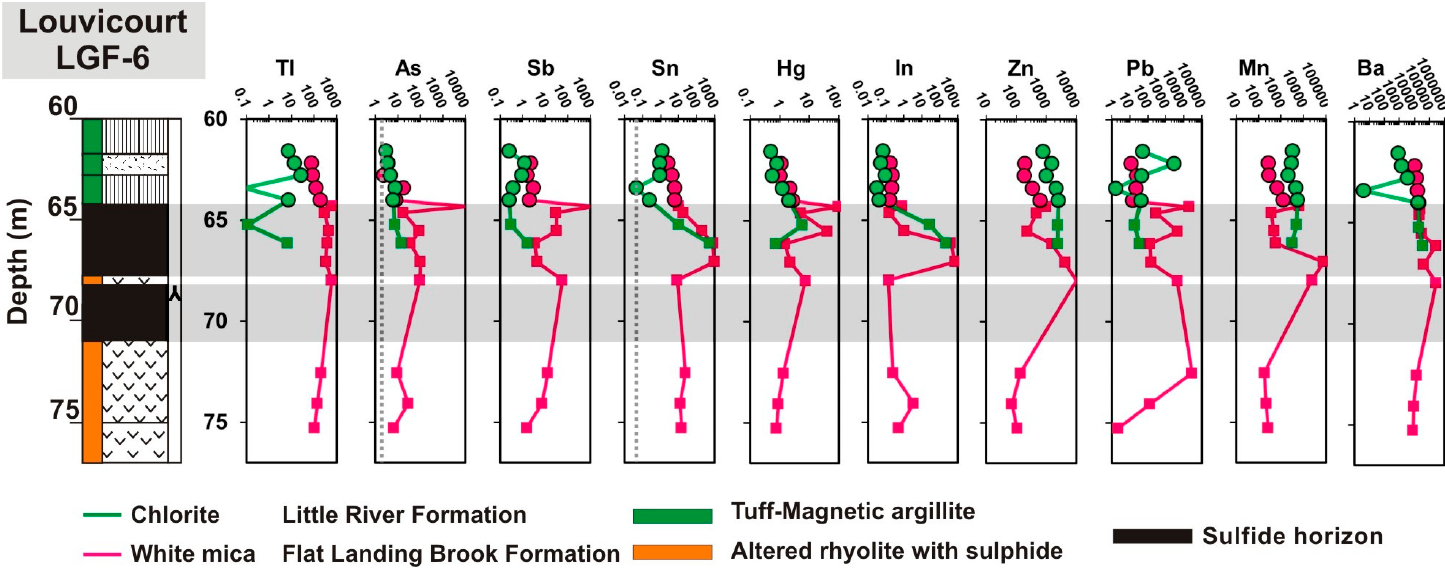
Figure 13. LA-ICP-MS geochemical data profiles illustrating fluid-mobile trace elements, as well as Zn, Pb, Mn, and Ba content (in ppm) of chlorite and white mica plotted with respect to the stratigraphy of Louvicourt deposit intersected by drill hole LGF-6 (see Supplementary Tables S6 and S7). Black outline symbols denote hanging wall samples.